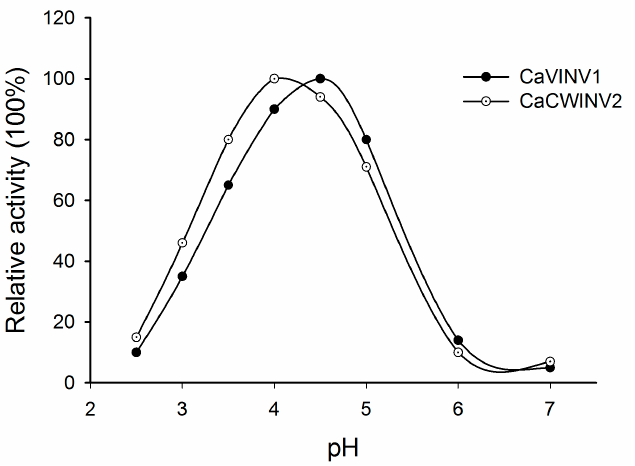
Figure 10. The pH dependence of the acid invertase activity of CaCWINV2 and CaVINV1.